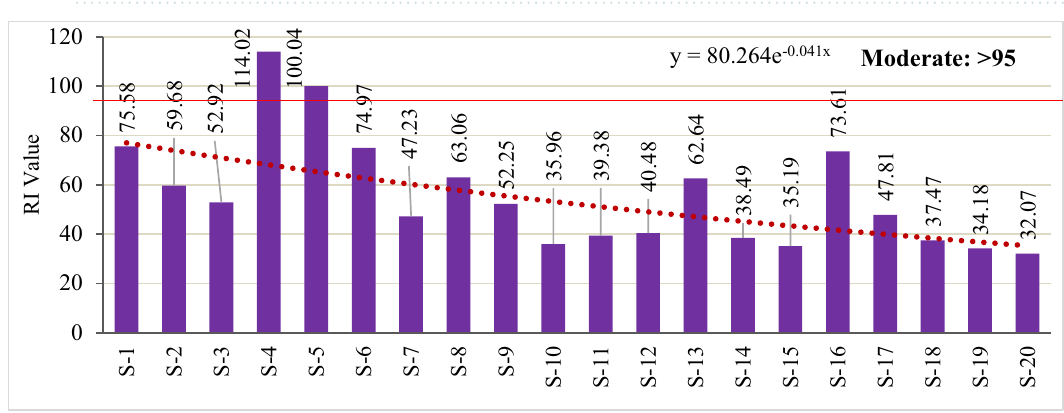
Figure 8. Potential ecological risk (RI) of studied trace metals in the Sundarbans